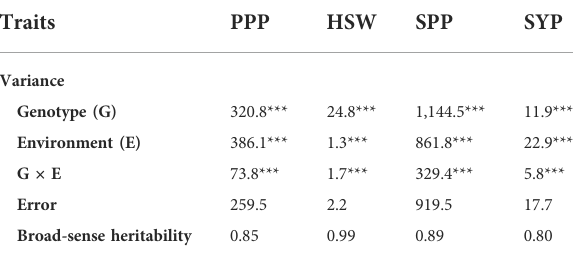
TABLE 1 Combined analysis of variance and broad-sense heritability for four yield and yield-related traits.